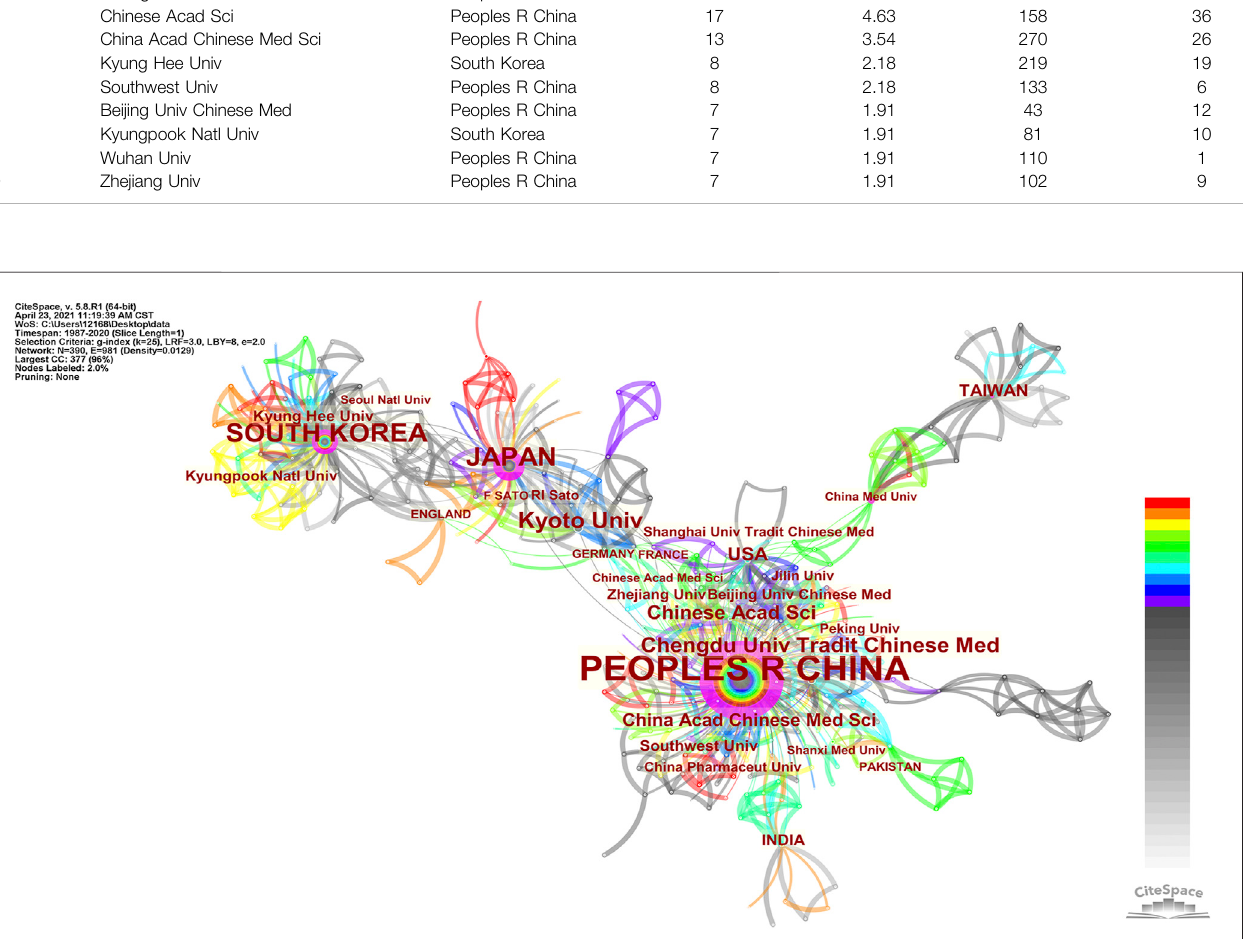
FIGURE 4 | Collaboration network of countries/regions and institutions in Coptis research.